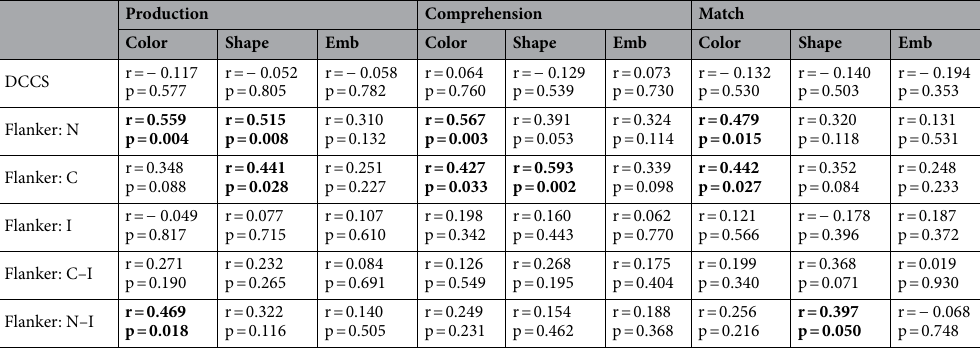
Table 1. Correlations between dimensional label tasks and EF tasks (flanker and DCCS). Significant correlations are highlighted in bold. N Neutral, I Incongruent, C